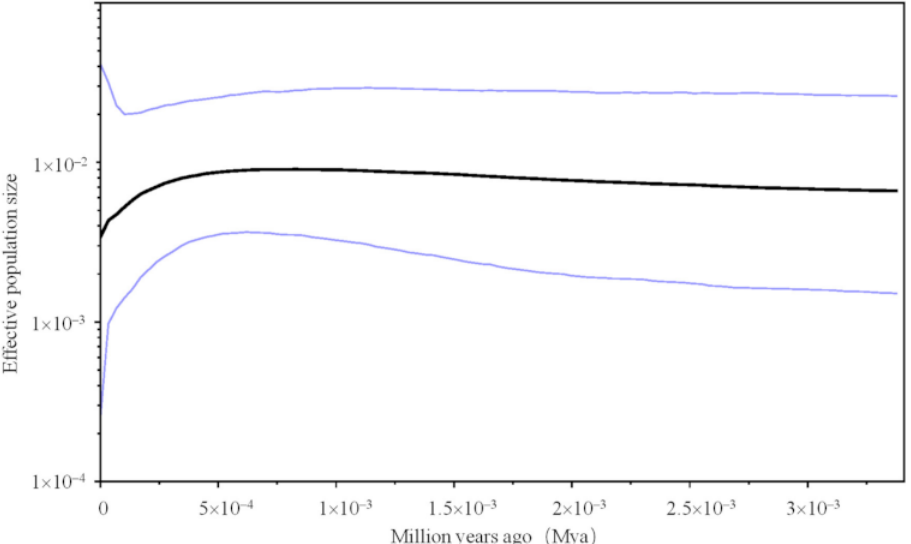
Figure 5. Bayesian skyline plot showing the historical demographic trend of Sus crofa in QM for the total samples. Time ( x -axis) represent in million years and population size ( y -axis) is measured as the product of effective population size per generation length. Dark lines represent median value inferred NE, blue lines mark the 95% highest probability density (HPD) intervals in all